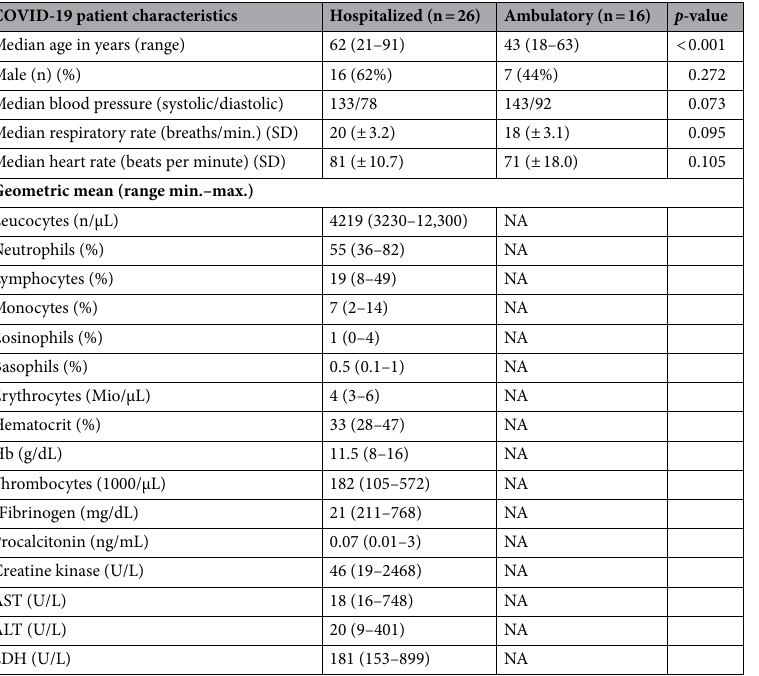
Table 1. Baseline characteristics of hospitalized and ambulatory COVID-19 patients. NA: not available, as mild COVID-19 were ambulatory patients without clinical complications; min.—minimum; max.—maximum; *Fibrinogen levels not available for one hospitalized